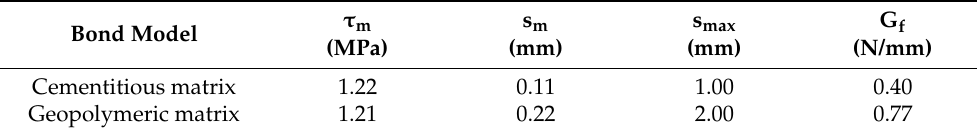
Figure 16. Bond–slip models at fabric–matrix interface data from [25]. Table 9. Key bond–slip model data from